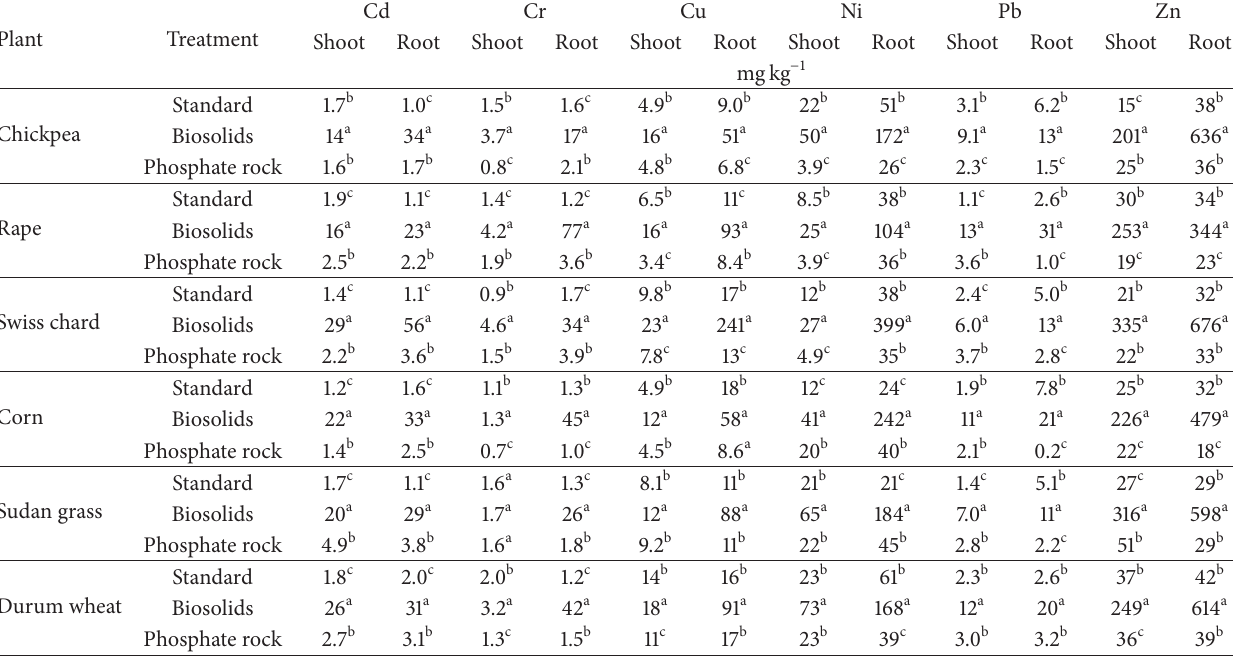
Table 5: Metal concentrations (means where 𝑛 = 3 ) of six plant species grown on sand media amended, without biosolids (Standard), with biosolids, and with phosphate rock †